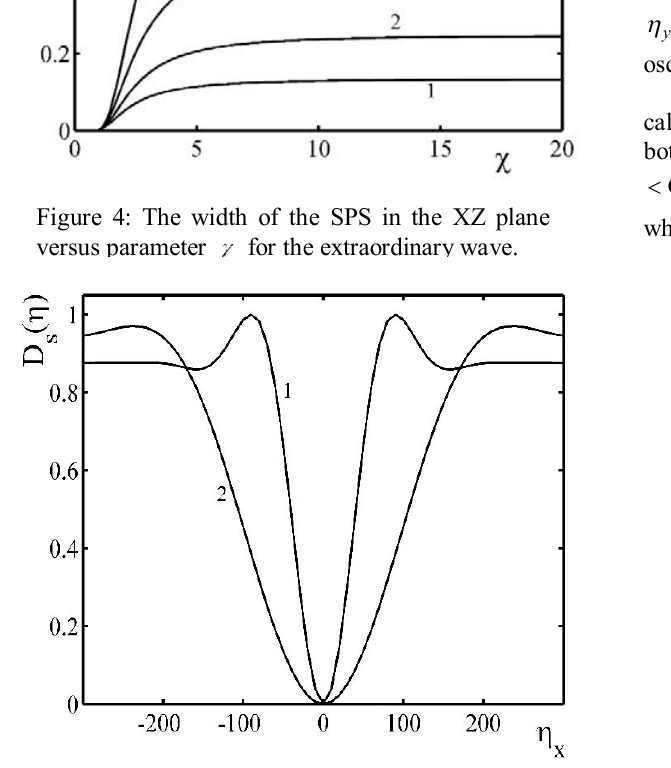
Figure 6: Scintillation index versus anisotropy factor for different characteristic spatial scale of plasma irregularities.